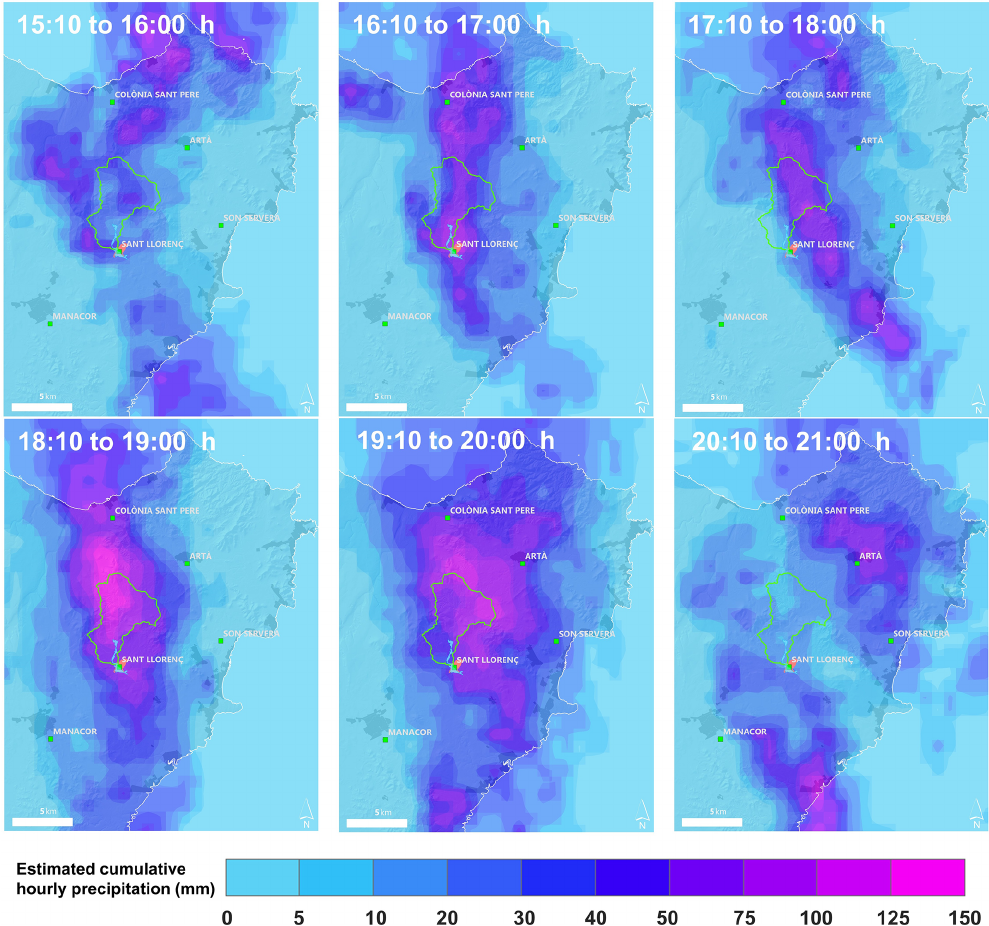
Figure 4. Evolution of the spatial distribution of the most intense hourly accumulated precipitations (i.e. ≥ 25mm) over eastern Mallorca between 16:00 and 21:00LT (14:00 and 19:00UTC) on 9 October